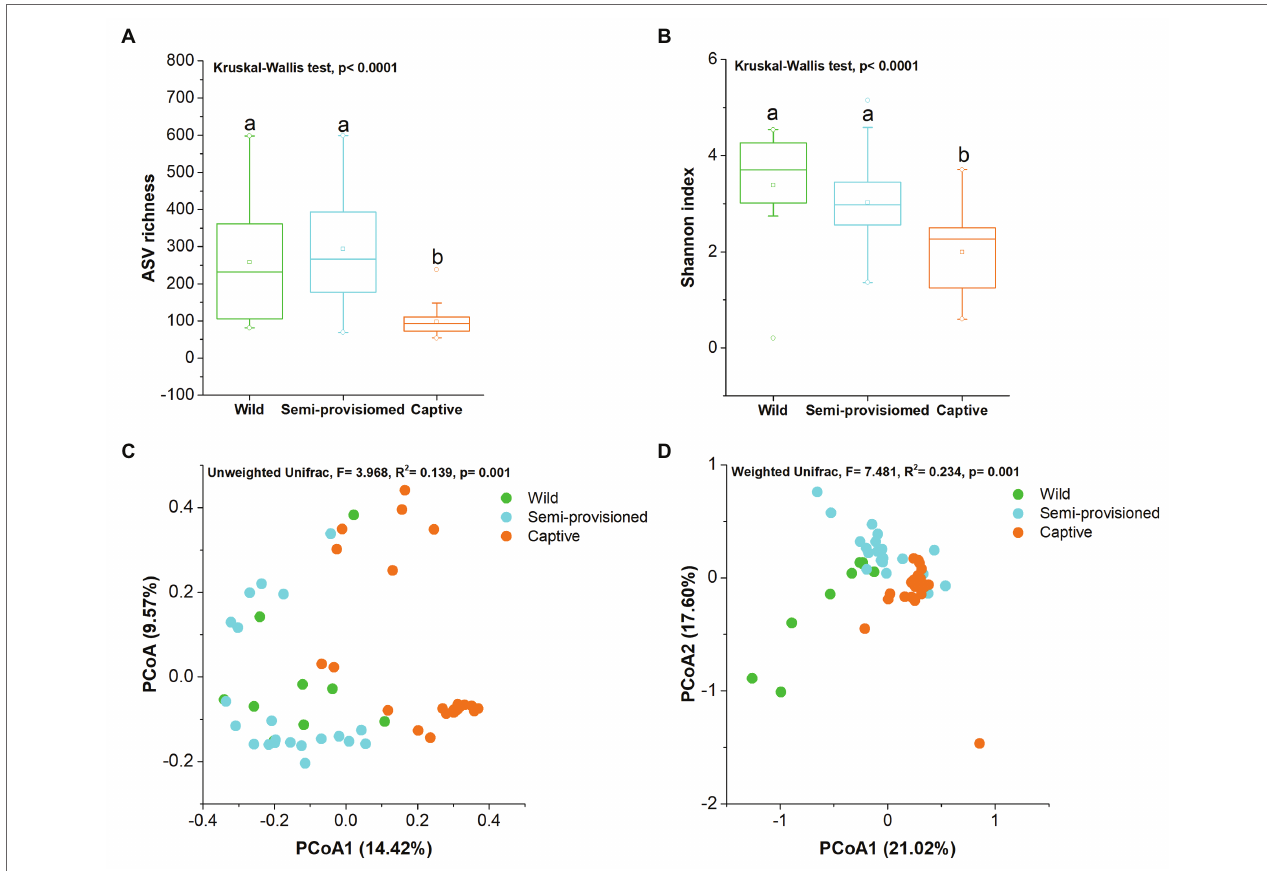
FIGURE 2 | Differences in fecal fungal diversity across three study groups. (A) Comparison of amplicon sequence variant (ASV) richness. (B) Comparison of Shannon diversity index. A Kruskal-Wallis ANOVA test was used to evaluate the variation across treatment groups. Post hoc tests (Dunn’s test) for pairwise comparison tests (values of p were adjusted by Bonferroni). (C,D) Differentiation of fecal mycobiota structure (C) based on unweighted UniFrac distance and (D) based on weighted UniFrac distance. Principal coordinates analysis (PCoA) was used to show patterns across three study groups. Adonis tests were performed on unweighted and weighted UniFrac, respectively. Significance was set at the 0.05